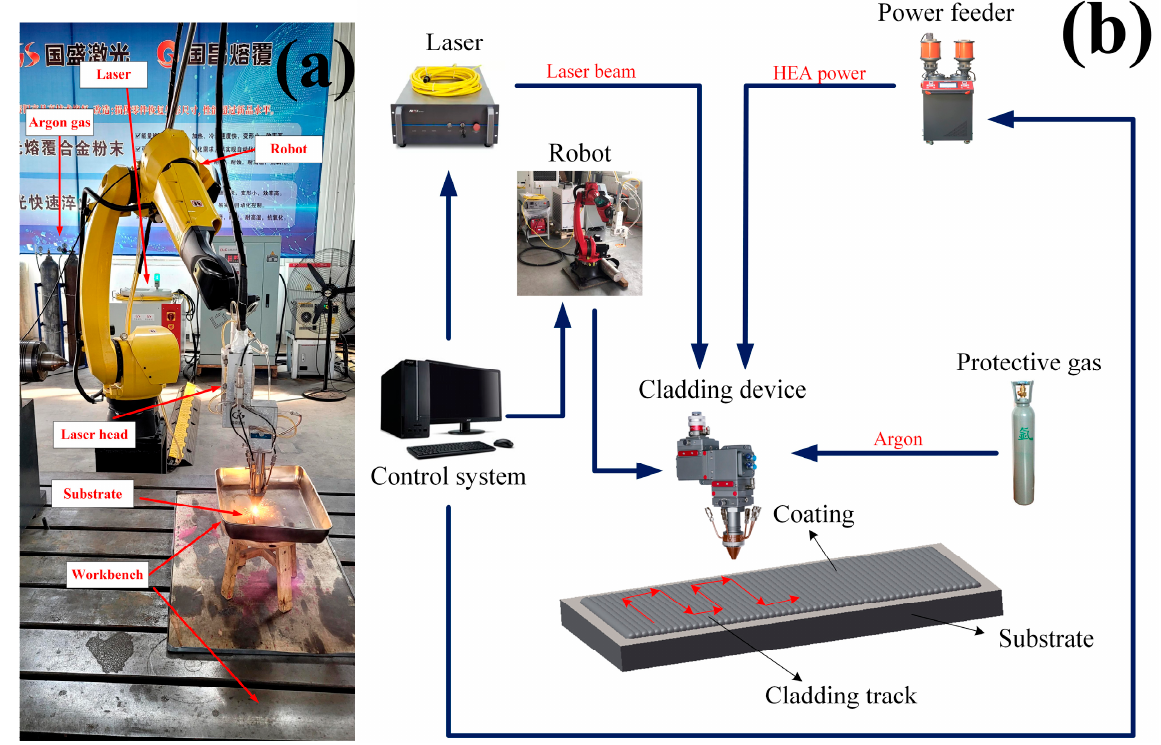
Figure 1. Laser cladding systems and equipment: ( a ) laser cladding equipment; ( b ) component modules of the fusion cladding system.